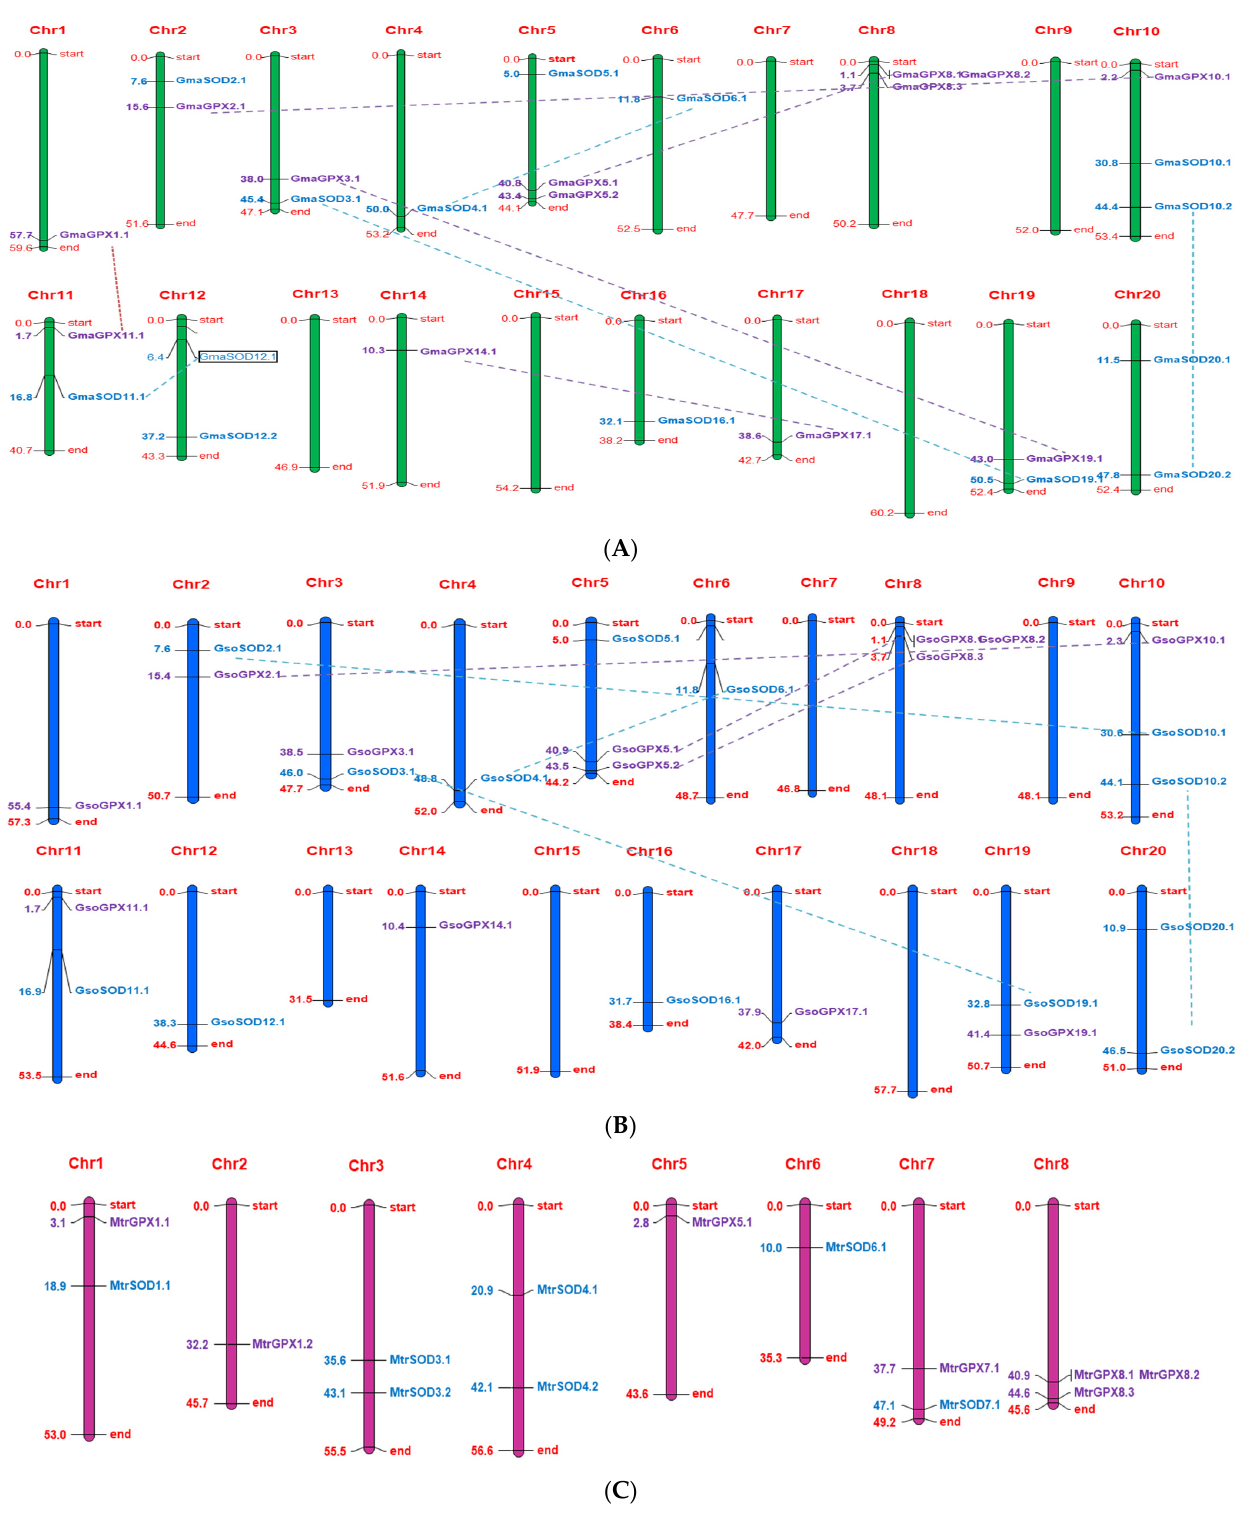
Figure 7. Chromosomal locations and gene duplication events of SOD and GPX genes of G. max ( A ), G. soja ( B ) and M. truncatula ( C ). The scale on the left side of chromosome is the position of the genes in megabases and on the right side of each chromosome gene names correspond to the approximate locations of each SOD and GPX gene. Furthermore, the segmentally duplicated genes are connected by dashed lines represented by the same color as SOD and GPX genes.